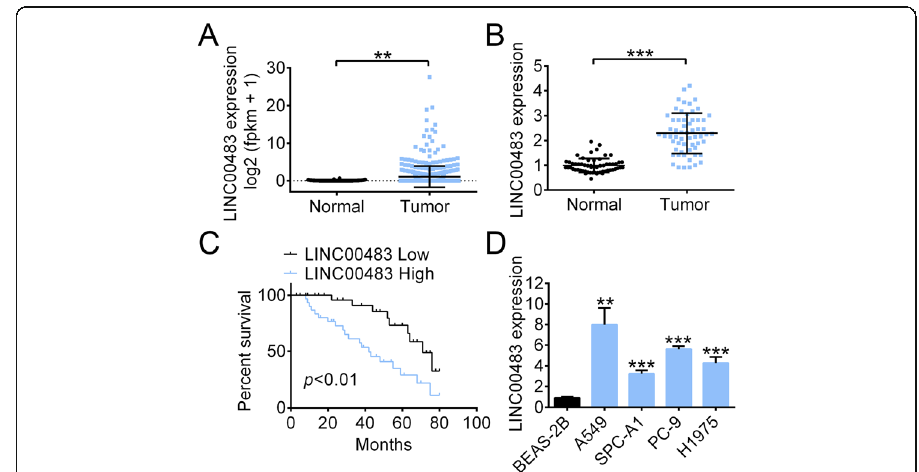
Fig. 1 LINC00483 expression was upregulated in LUAD tissues and cells. a Analysis of LINC00483 expression in LUAD tissues and normal tissues based on the cancer genome atlas database. b The RNA level of LINC00483 in LUAD tissues and normal tissues was measured using quantitative real-time PCR ( n = 60). c Analysis of correlation between the survival time of LUAD patients and LINC00483 expression. d The RNA level of LINC00483 in cell lines was measured using real-time PCR. LUAD: lung adenocarcinoma, ** p < 0.01; *** p <